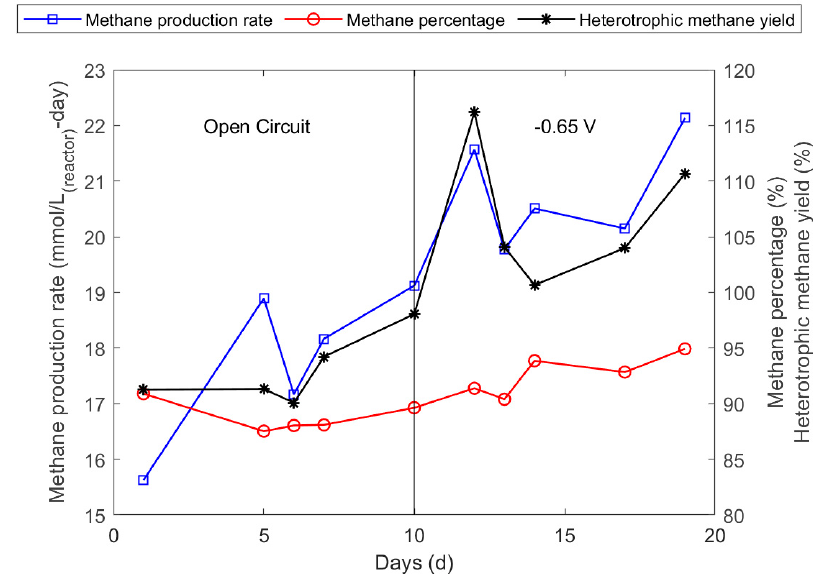
Figure 7. Comparison of methane production and efficiency in open circuit and MES mode operations.